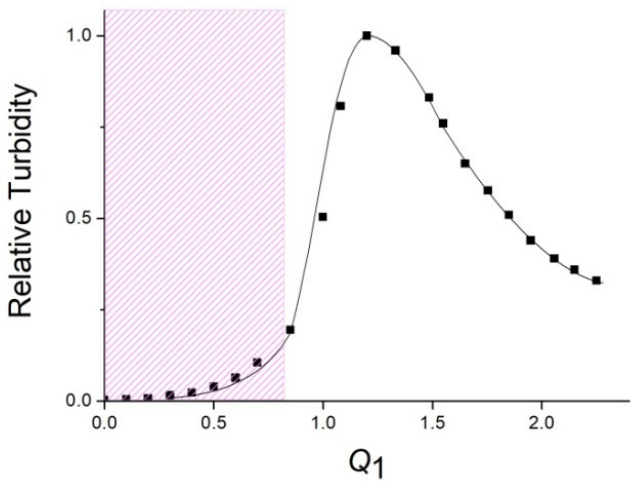
Figure 1. Relative turbidity of IPEC solution at λ = 500 nm vs. Q 1 = [ALG]/[QHECE]. [QHECE] = 5 × 10 − 4 М ; 10 − 2 М phosphate buffer of pH 7. The cross-hatched region represents water-soluble IPECs.